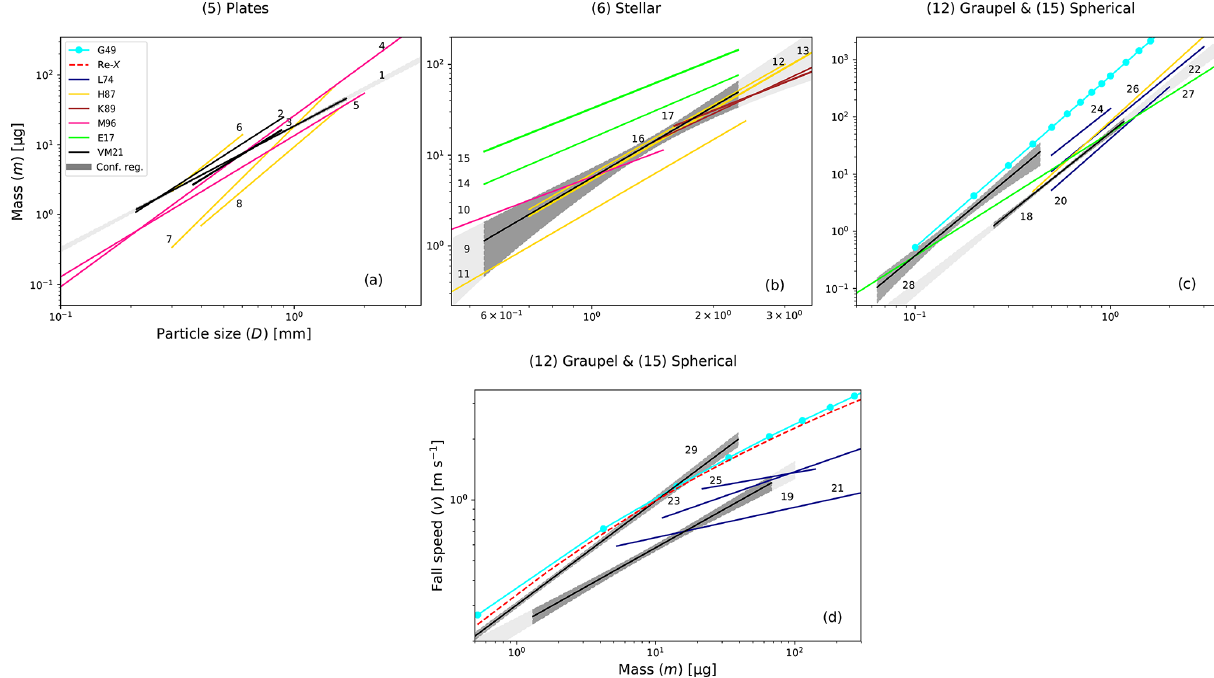
Figure 3. A comparison of the mass vs. particle size ( m vs. D ) and fall speed vs. mass ( v vs. m ) relationships of this study and previous studies for some shape groups: (5) Plates , (6) Stellar , (12) Graupel , and (15) Spherical are shown in logarithmic scale. (a–c) The m vs. D relationships for (5) Plates , (6) Stellar , (12) Graupel , and (15) Spherical , respectively. (d) The v vs. m relationships for (12) Graupel and (15) Spherical . For the comparison, parameterizations from Gunn and Kinzer (1949) (G49), Locatelli and Hobbs (1974) (L74), Heymsfield and Kajikawa (1987) (H87), Kajikawa (1989) (K89), Mitchell (1996) (M96), and this study (VM21) are shown. In (c) , the line by G49 · ρ w · D 3 that was shown also in Fig. 1a. In (d) , for comparison, a line for speeds corresponds to the mass of spheres given by m = π 6 determined from Eq. (2) using Re from Eqs. (3) and (4) for spherical particles with density ρ w = 1gcm − 3 is added as a dashed red line. This line is referred to as Re – X . These m vs. D and v vs. m relationships are the same shown and enumerated in Table 2. The power laws that correspond to VM21 are shown together with their respective 68% confidence regions. The length of all relationships corresponds to the ranges of D and m on the x axis (see Table